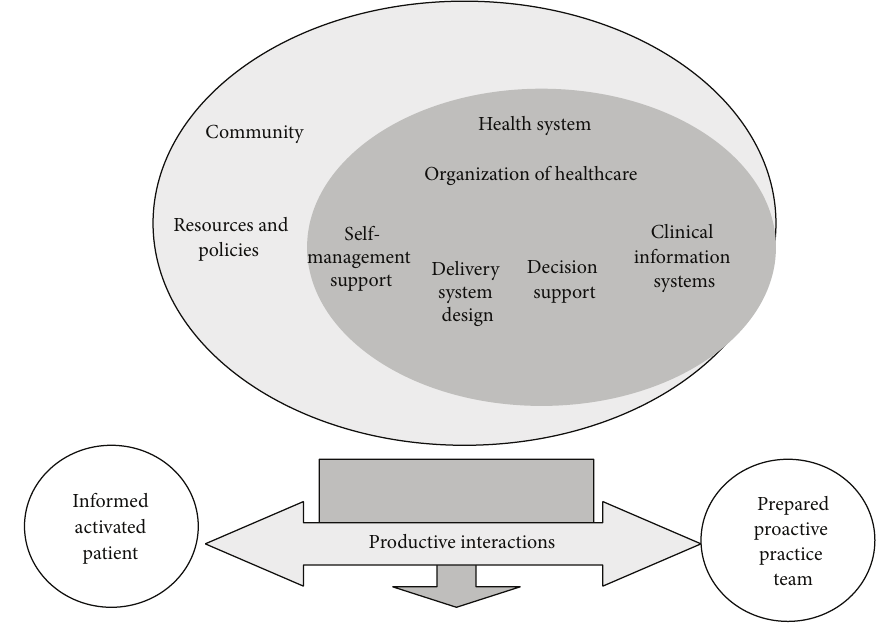
Figure 1: The Chronic Care Model (CCM)